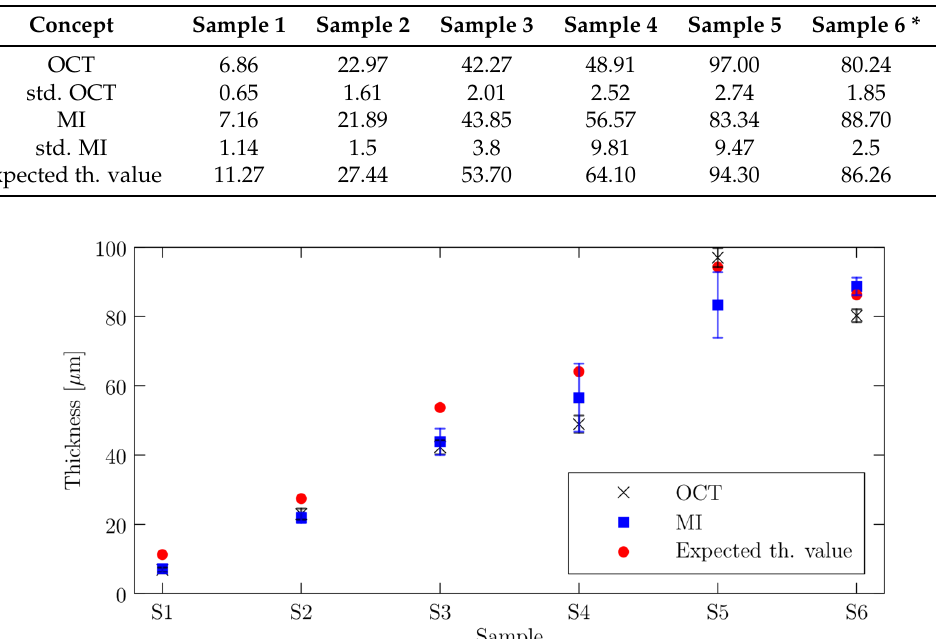
Figure 4. Comparison between OCT and MI measurements and the calculated theoretical value.